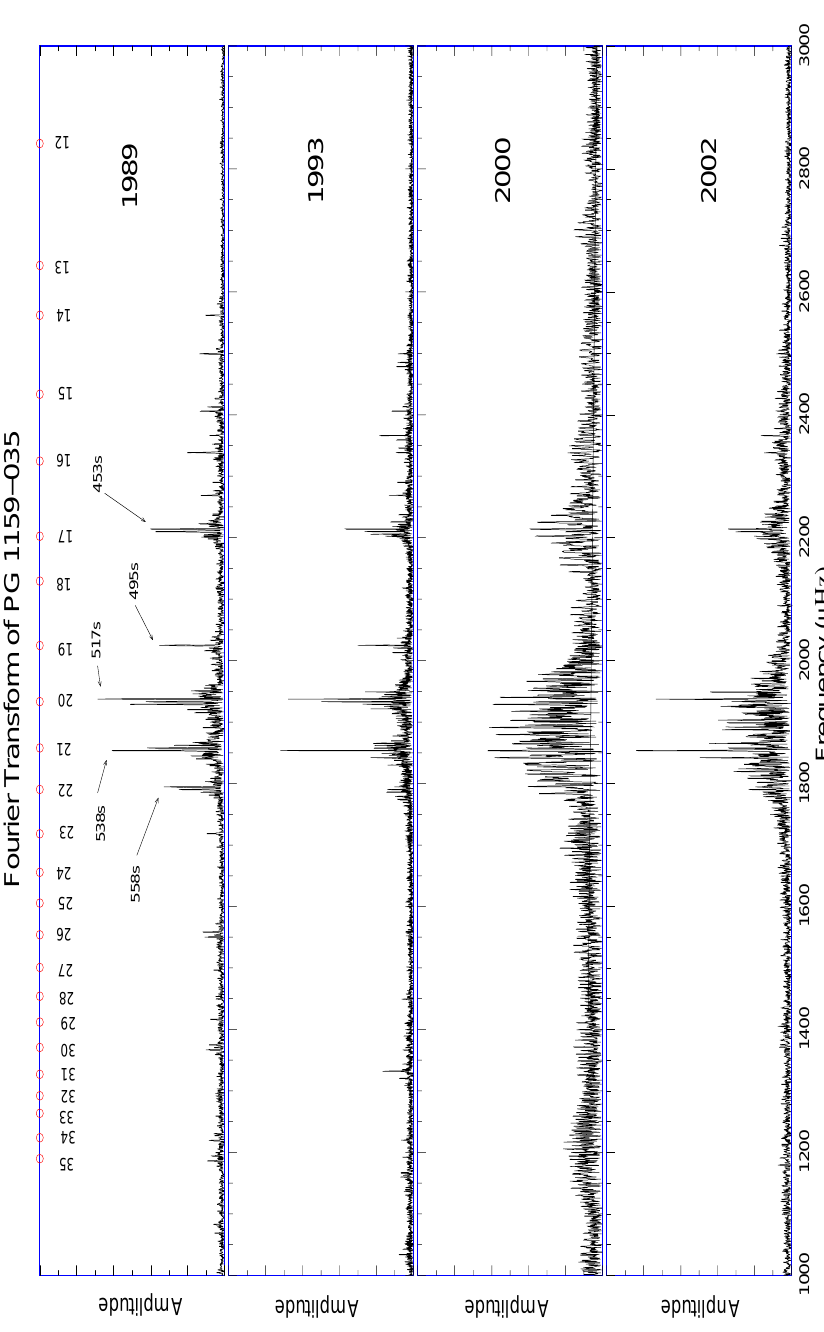
Fig. 1. Discrete Fourier Transform of PG 1159-035 XCOVs light